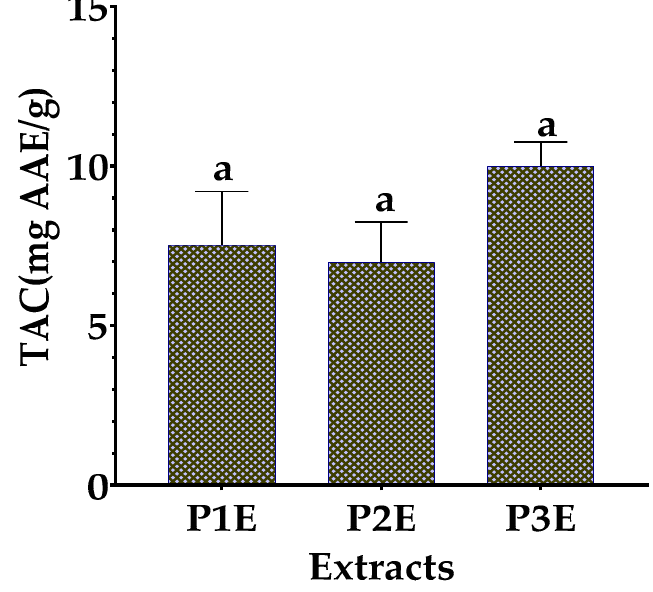
Figure 5. TAC values of PE1, PE2, and PE3; AAE: ascorbic acid equivalents; a: the difference between the three samples was not significant ( p > 0.05).